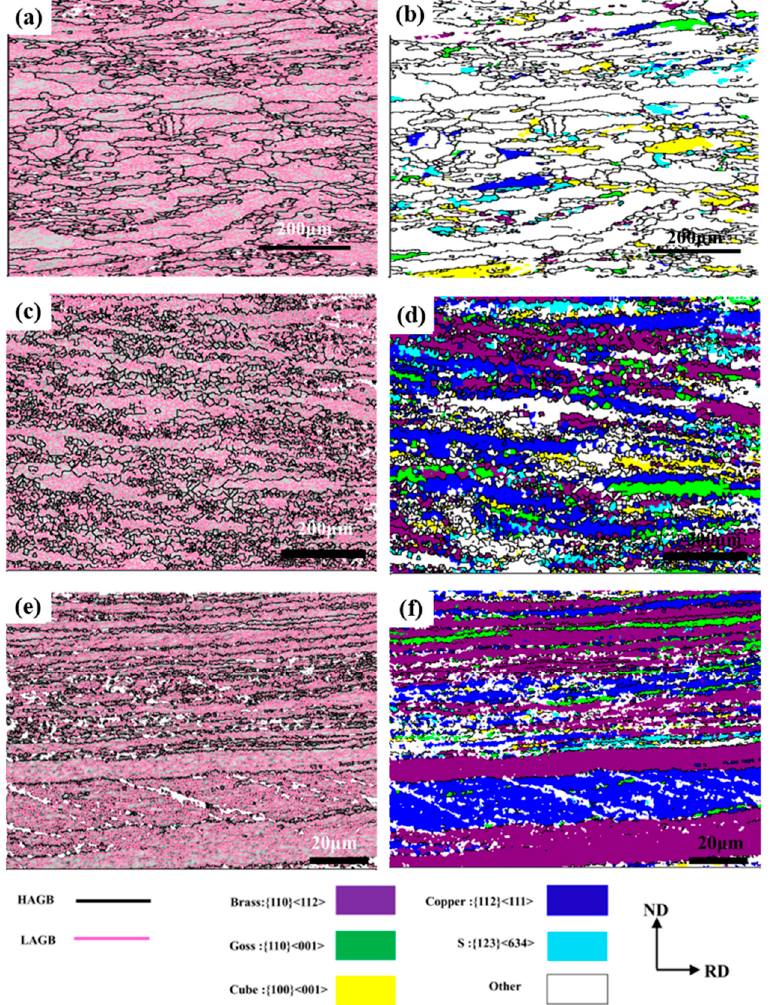
Figure 7. Grain boundary diagram ( a , c , e ), and crystal orientation map ( b , d , f ) of Cu-0.1Al alloy under unidirectional rolling: ( a , b ) UR-54%; ( c , d ) UR-70%; ( e , f ) UR-90%.